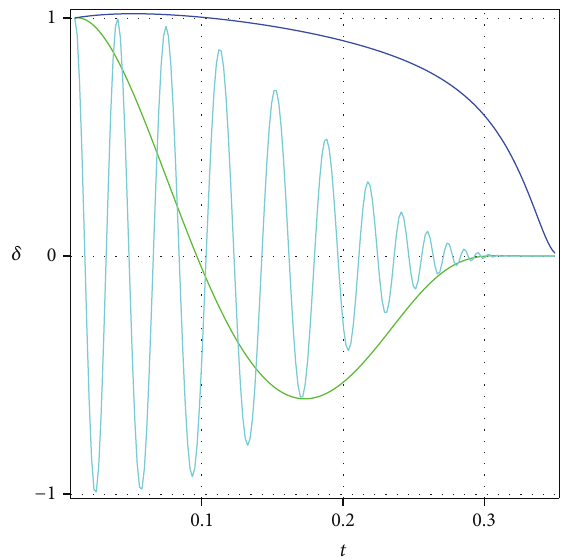
Figure 14: Time evolution of 𝛿 for 𝐵 = 3 , 𝐶 2 = 1 , 𝛼 = 0.5 , 𝑛 = 2 , and 𝐴 = 1/3 . 𝑘 = 0 (blue line), 𝑘 = 10 (green line), 𝑘 = 100 (cyan